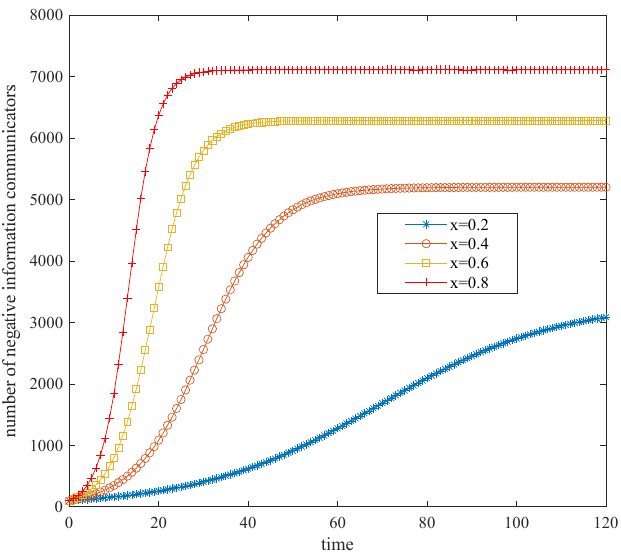
Figure 5. The spread of COVID-19 public opinion under negative emotional tendencies.